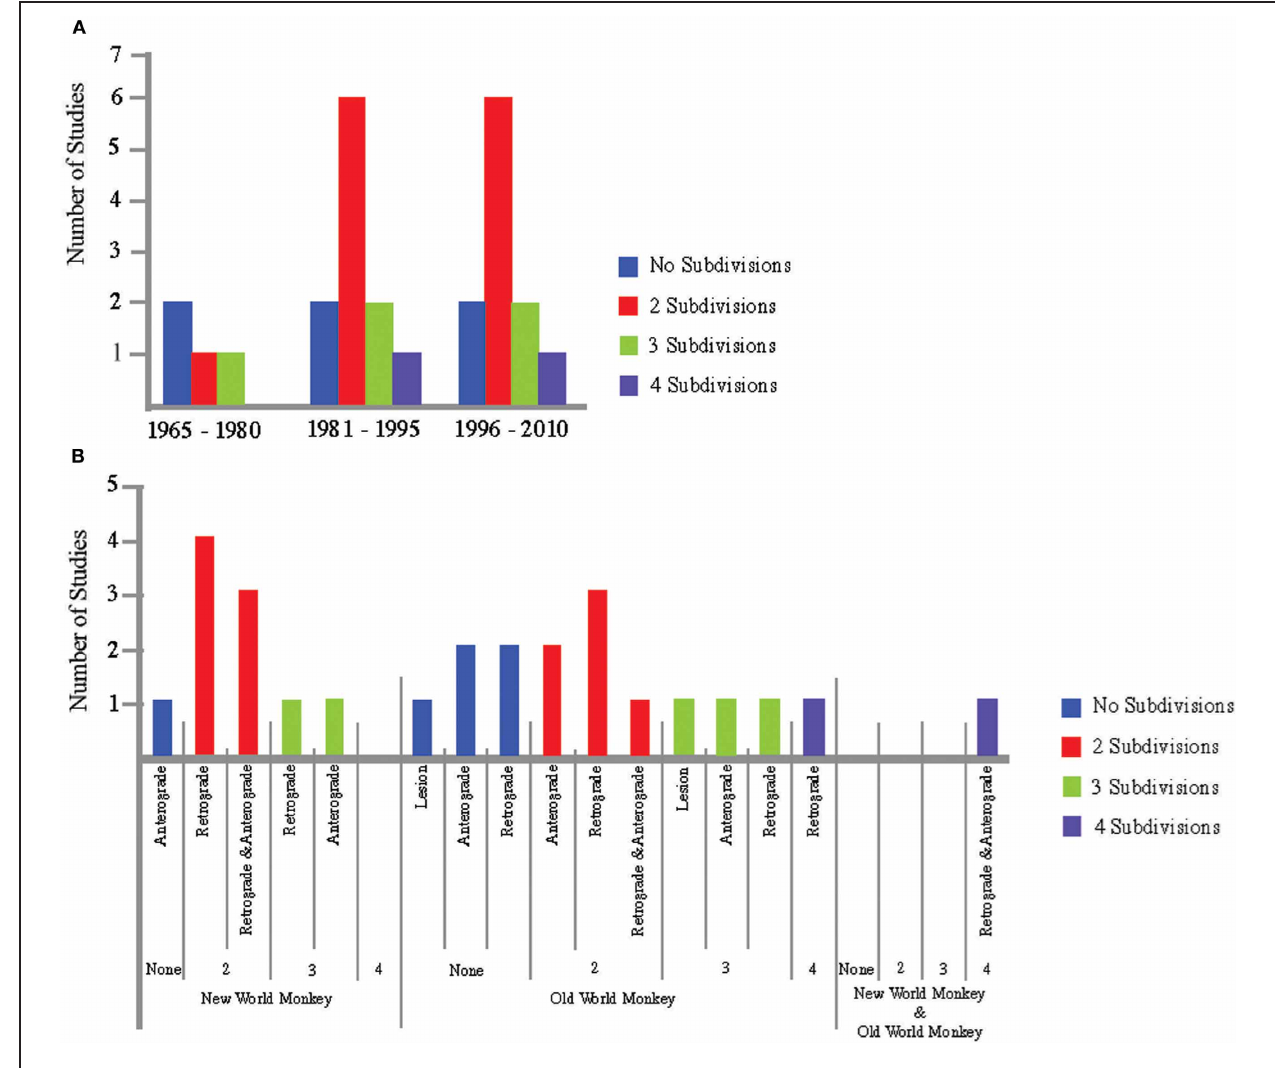
FIGURE 2 | Reported number of subdivisions sorted by the year of publication, method and species. (A) Histogram including studies that argue for subdivisions in the STN published during the past 45 years, summarized in time-windows of 15 years. (B) Histogram including studies that argue for subdivisions in the STN separated for